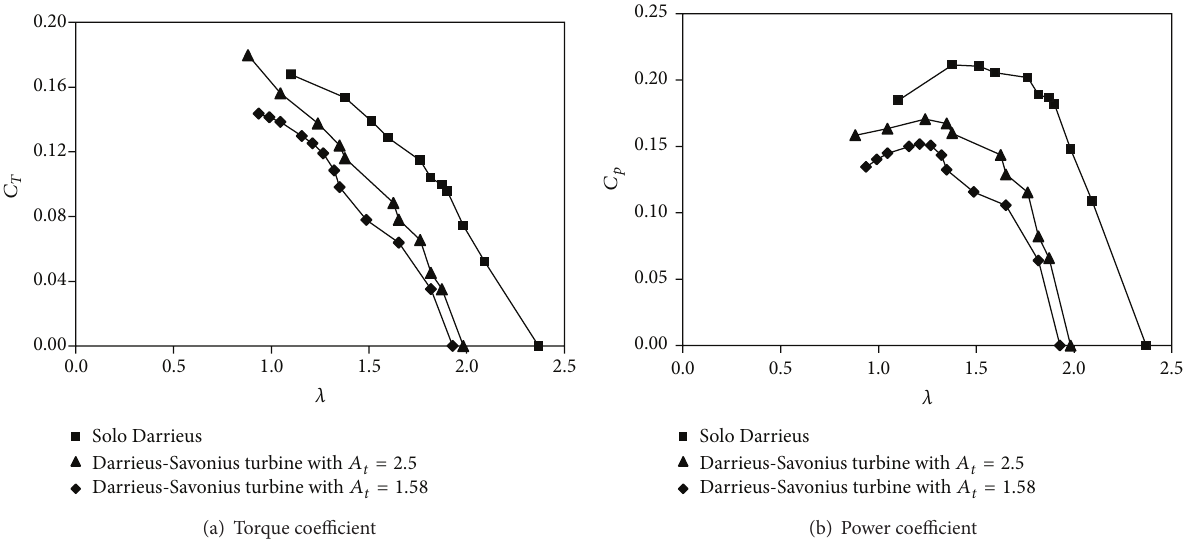
Figure 5: Characteristics performance of Darrieus-Savonius turbine without deflector.